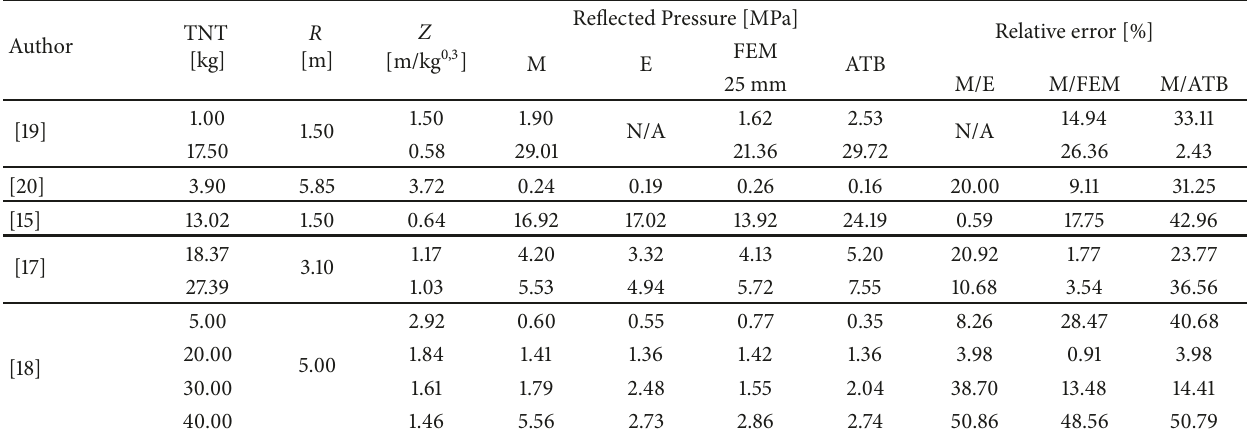
Table 14: Reflected pressure